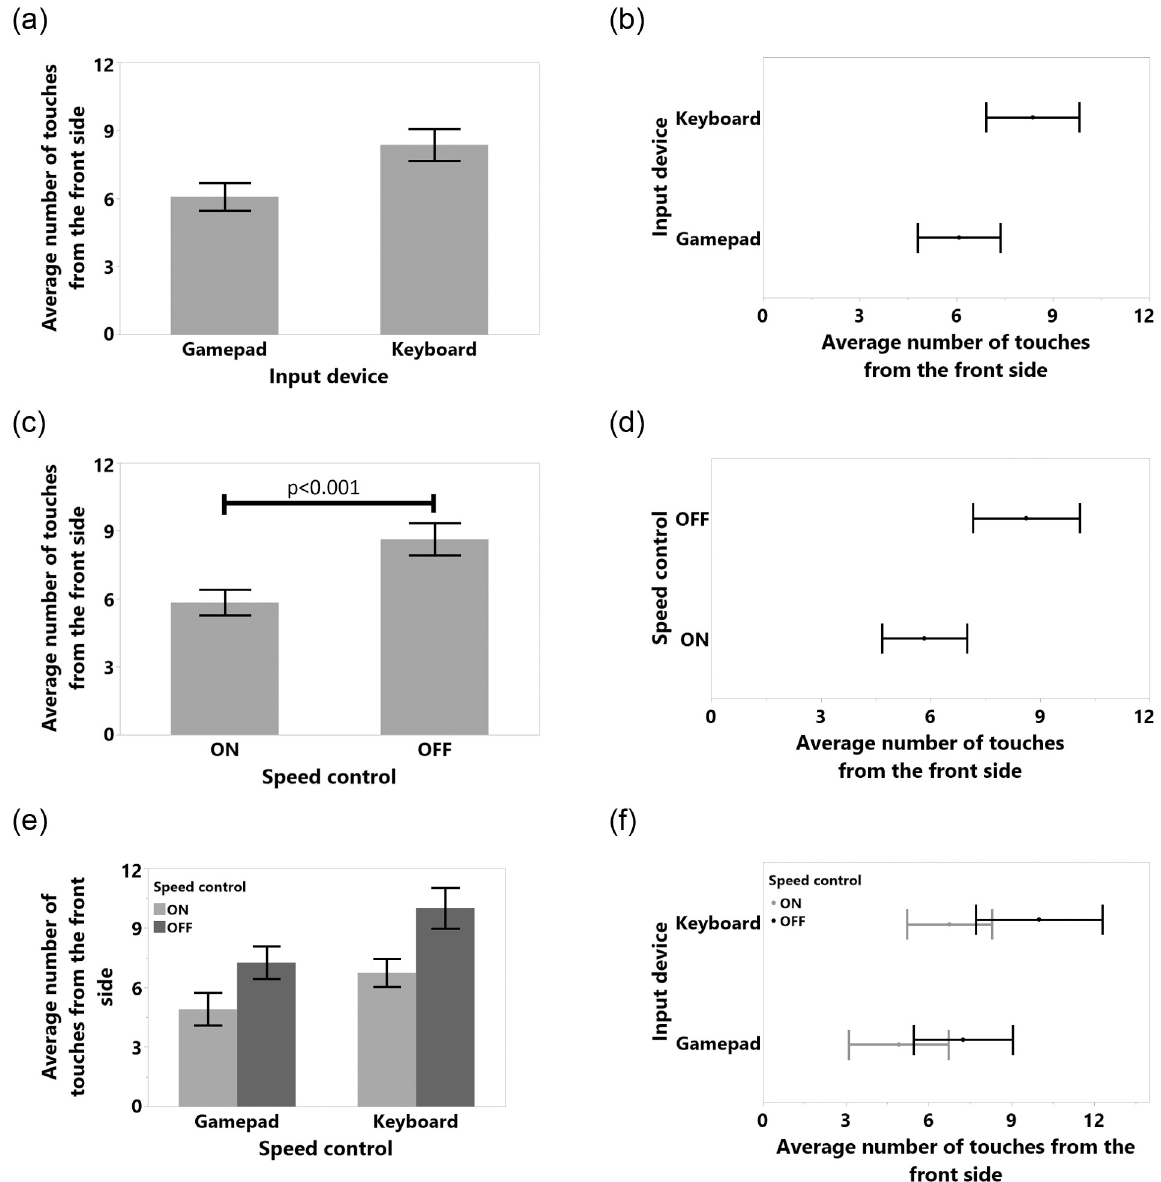
Fig 8. Means and standard error of means for number of touches from the front side for (a) input device, (c) speed control, (e) input device and speed control interaction. Means and 95% confidence intervals for number of touches from the front side for (b) input device, (d) speed control, (f) input device and speed control